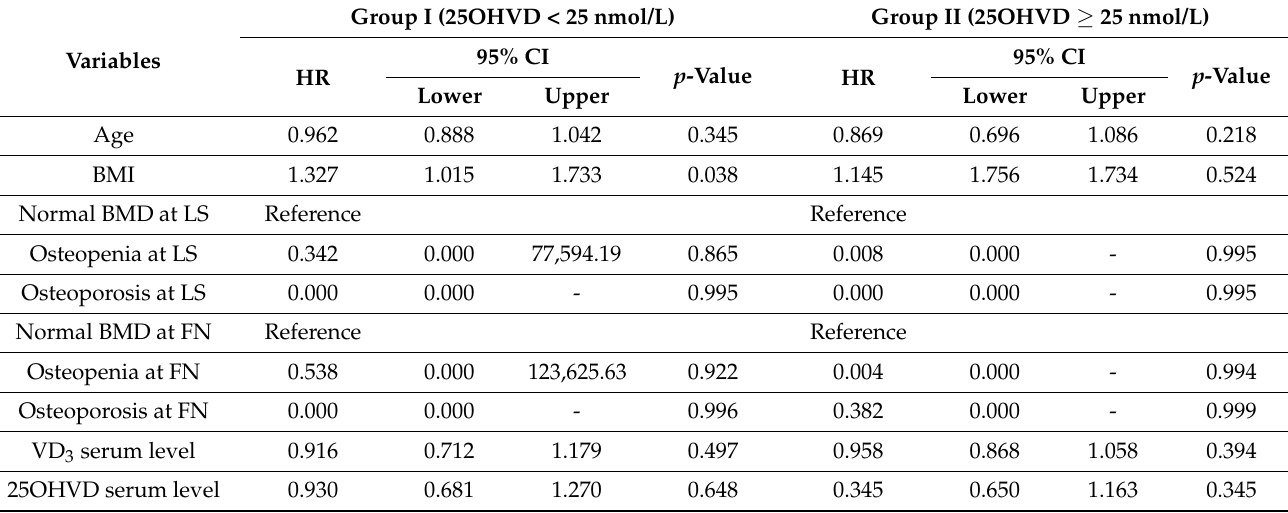
Table 4. Multivariable Cox proportional hazards regression model based on pretransplant